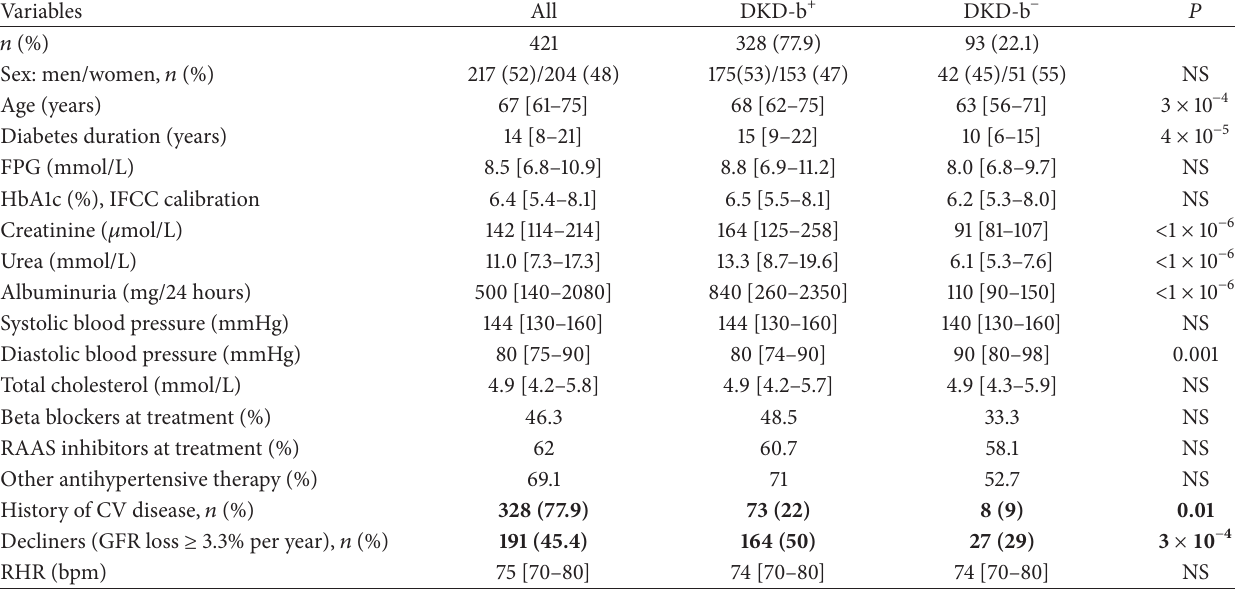
Table 2: Clinical and biochemical characteristics of subjects divided according to history of DKD, baseline data. Variables